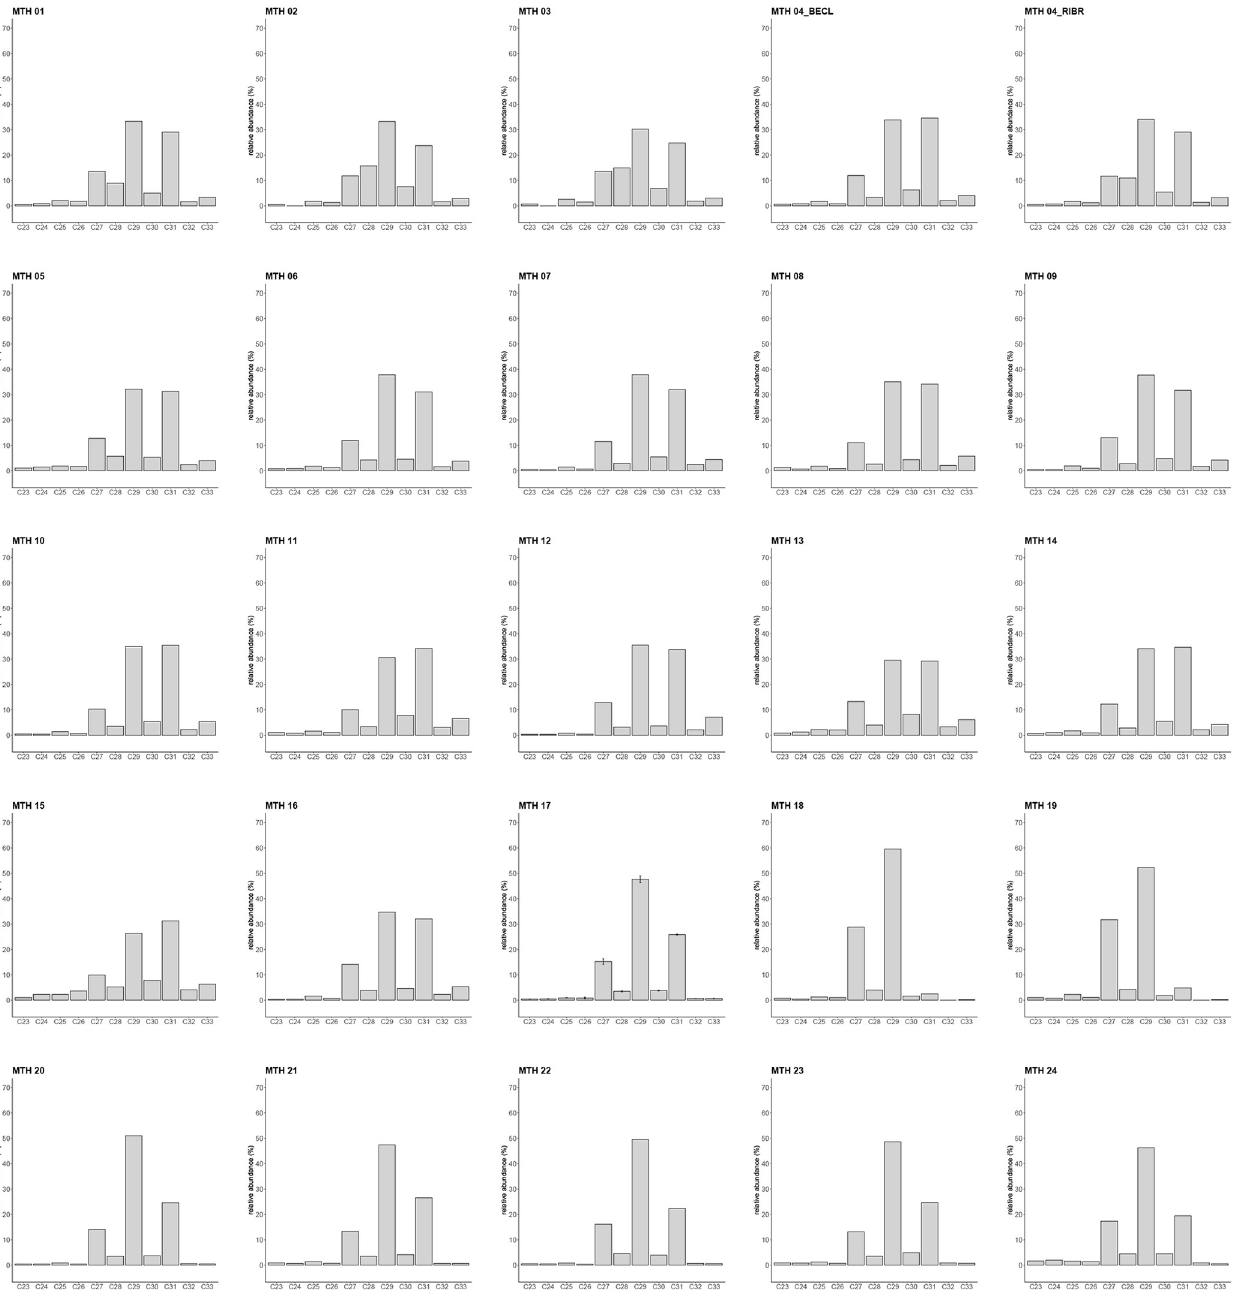
Figure B1. Sample fingerprints: relative abundances (%) of the n -alkane chain lengths per sample. Samples that were measured repeatedly show average relative abundance (%) and standard deviation from the average relative abundance (lines); see also Table A1. Graph titles refer to sample field codes and sample type, where numbers without a prefix indicate necromass samples, the BIOM prefix indicates soil samples and the GK, MCL, MTH, MBR, MCO, and MOC prefixes indicate plant